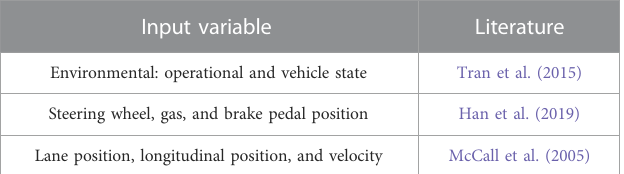
TABLE 1 Summary of environmental